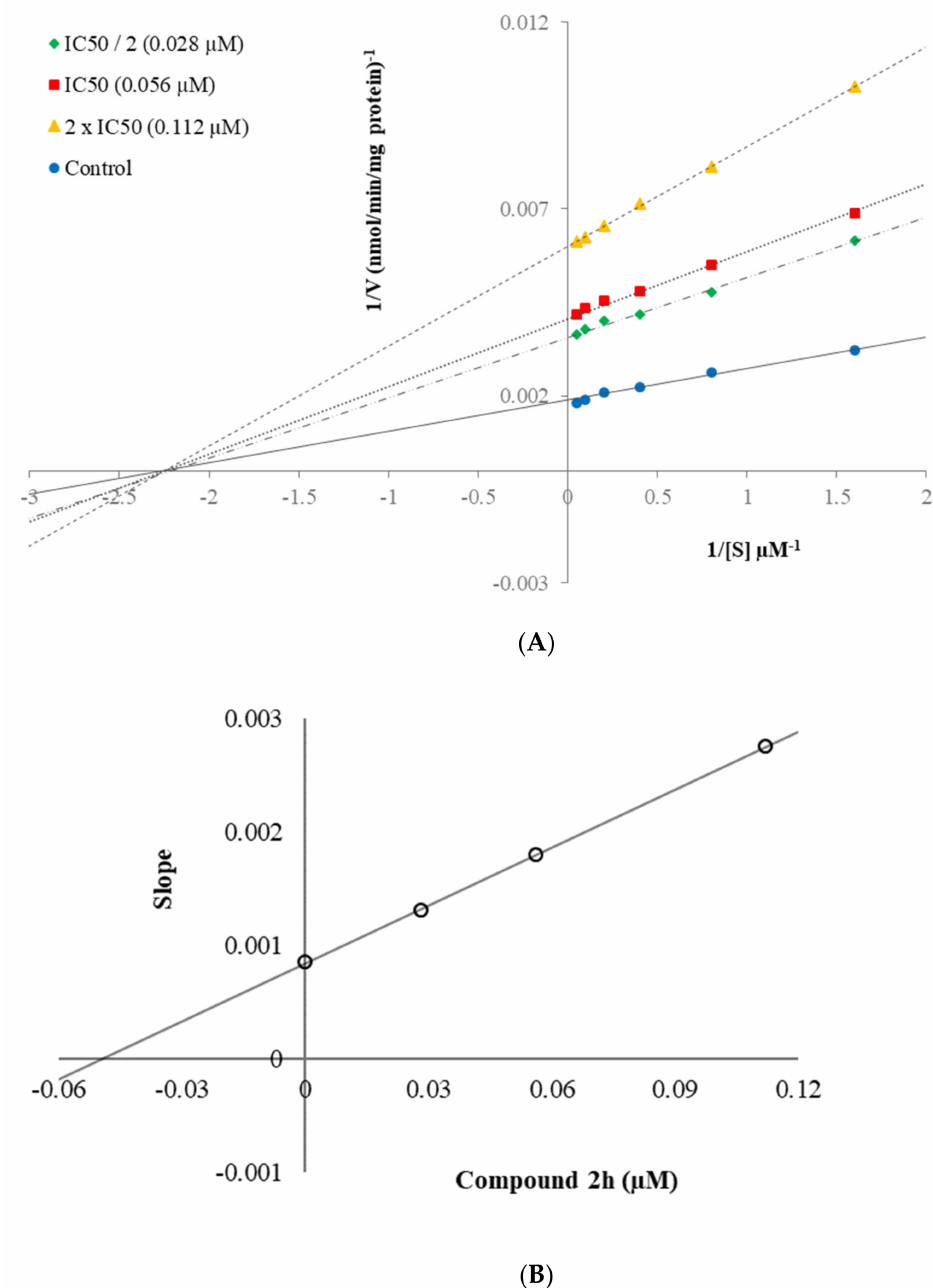
Figure 5. ( A ) Lineweaver–Burk plots for the inhibition of hMAO-B by compound 2h . [S], substrate concentration ( µ M); V, reaction velocity (nmol/min/mg protein). Inhibitor concentrations are shown at the left. ( B ) Secondary plot for the calculation of the steady-state inhibition constant (K i ) of compound 2h . K i was calculated as 0.046 µ